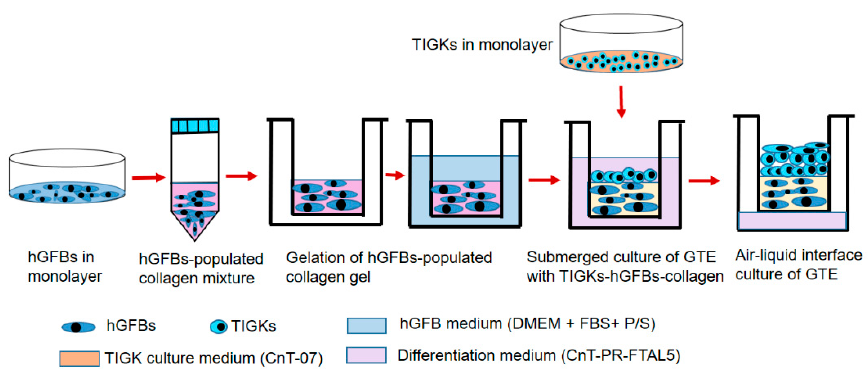
Figure 7. Workflow chart showing the procedure of gingival tissue equivalent (GTE) generation. Abbreviations: hGFBs: hTERT-immortalized gingival fibroblasts; TIGKs: hTERT-immortalized gingival keratinocytes.